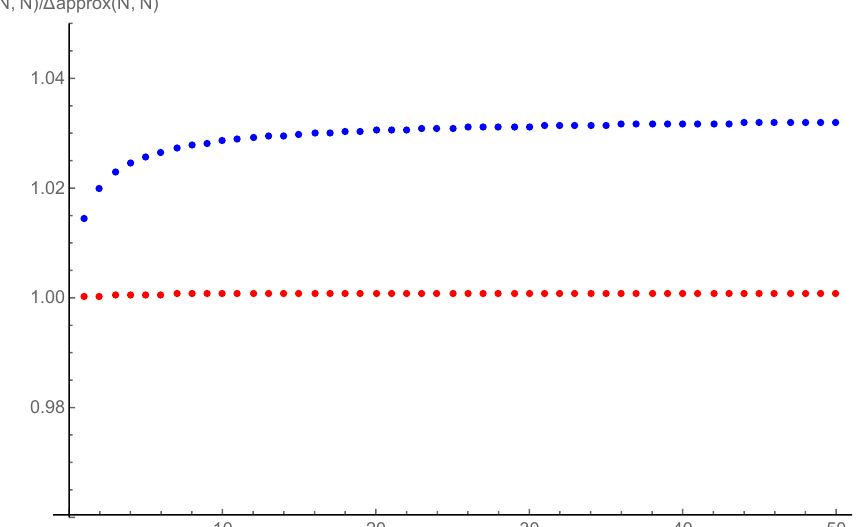
Figure 15 . The N dependence of the ratio of (cid:1)( N; N ), the exact value at the GWW transition point, to the leading one-instanton strong-coupling large N contribution (cid:1) circles], and then including also the three-instanton contribution (cid:1) The agreement is excellent, even at small values of N